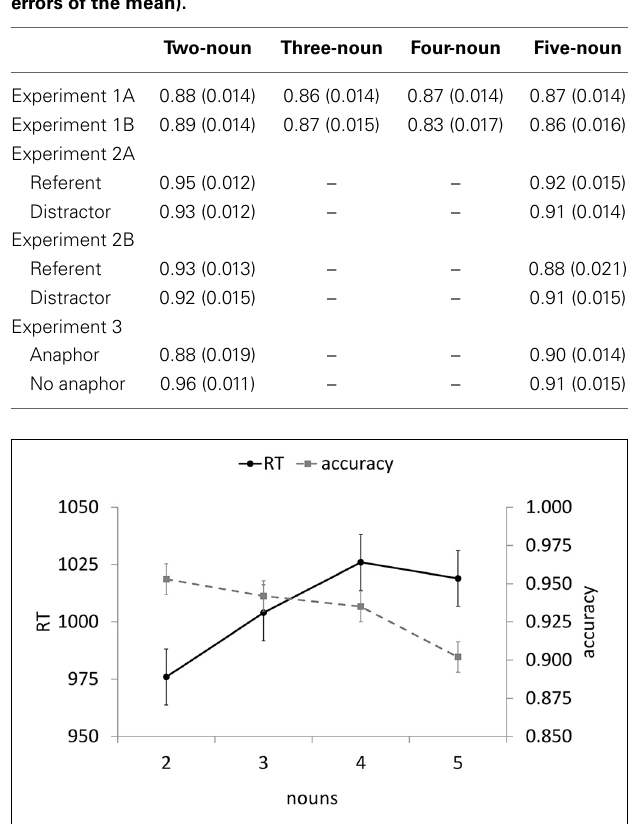
FIGURE 1 | Experiment 1A antecedent probe reaction times and accuracies by noun condition (error bars indicate SE of the